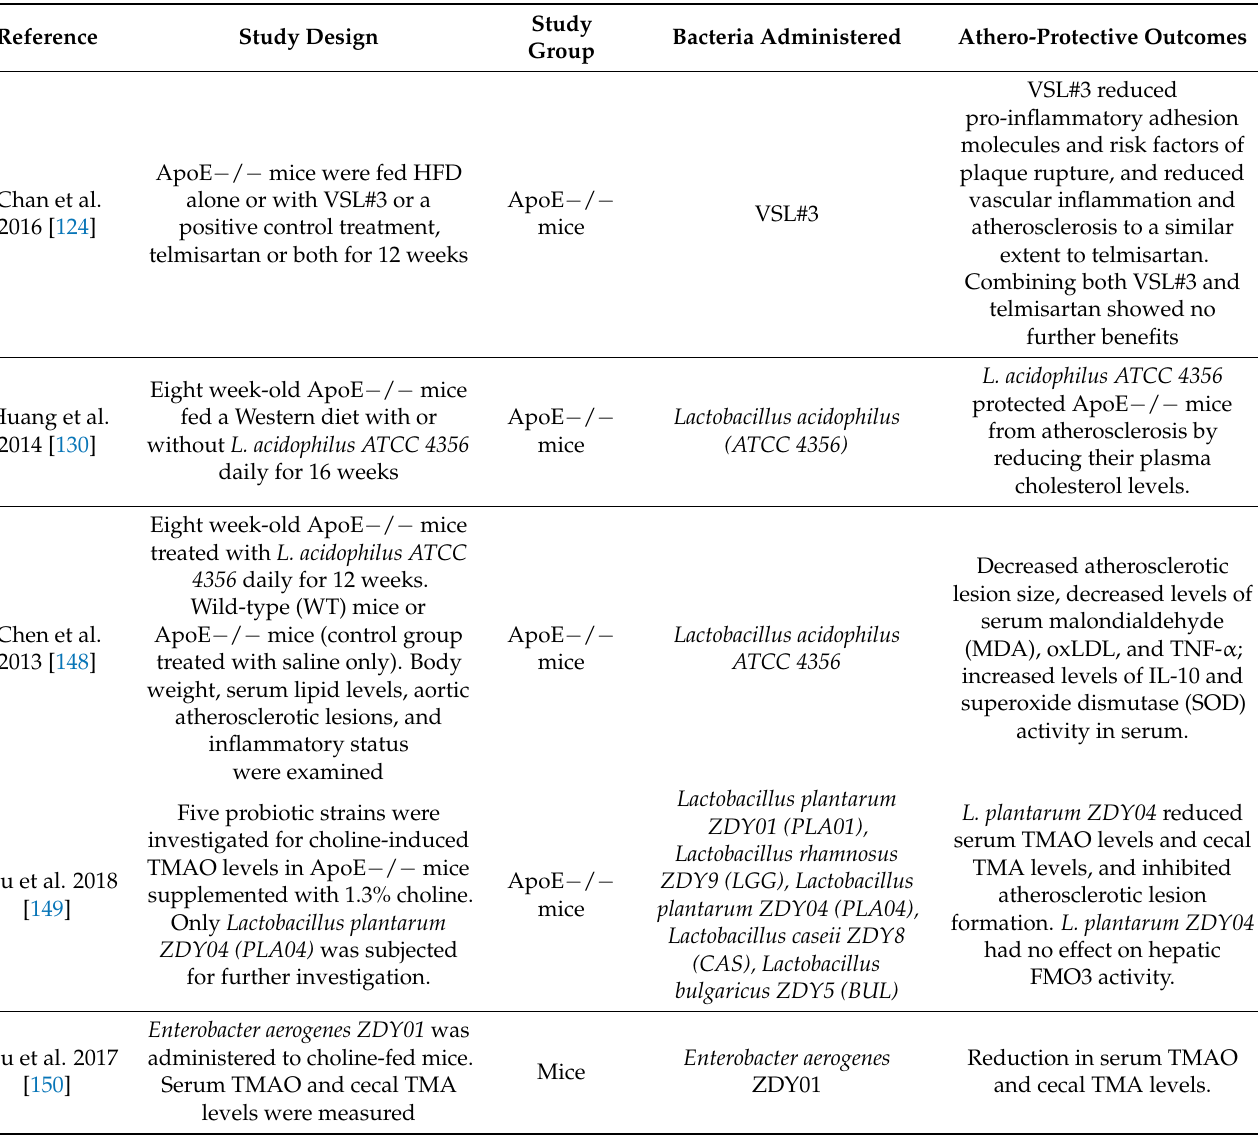
Table 1. Anti-atherogenic effects of probiotics in human and animal